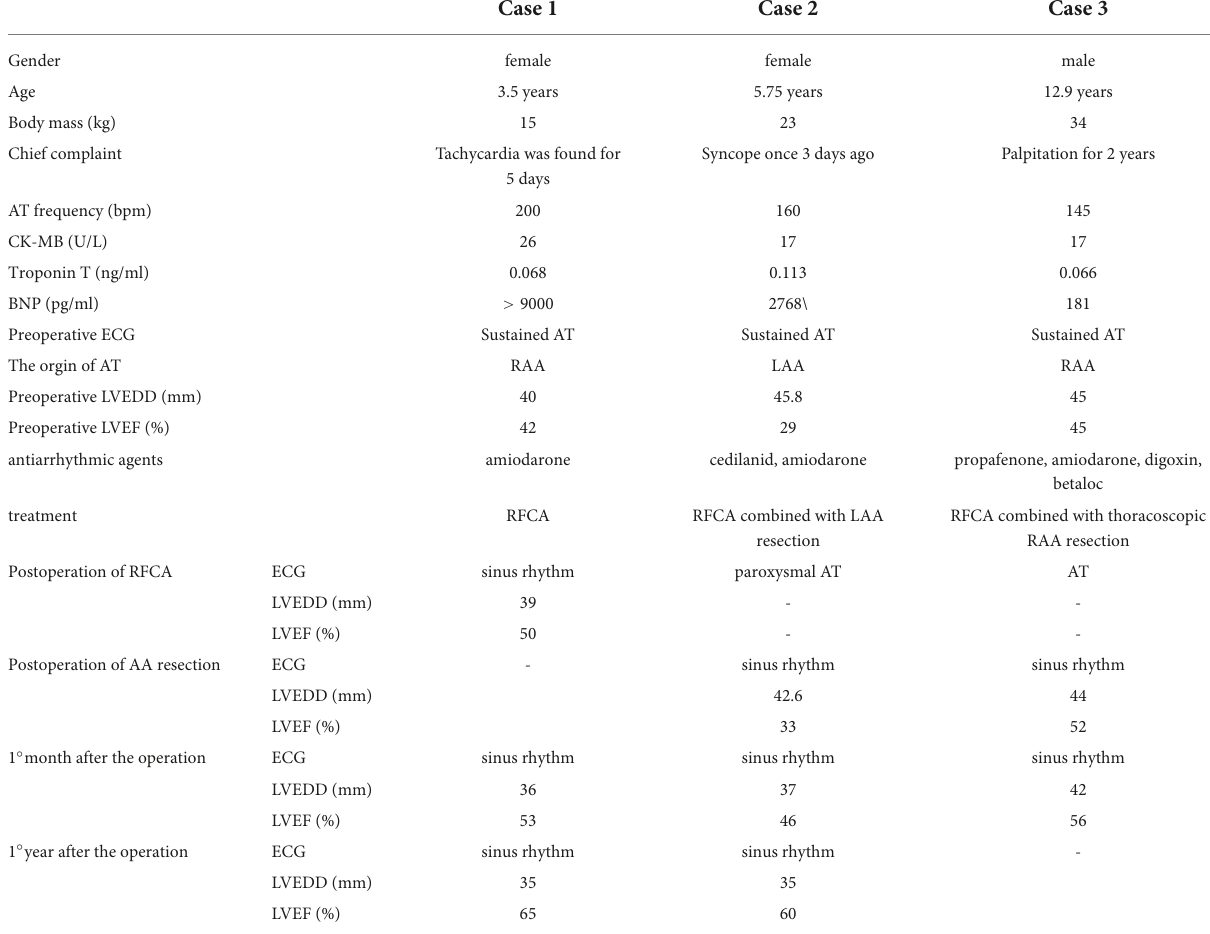
TABLE 1 Clinical features and efficacy analysis of three cases of atrial tachycardia originating from the atrial